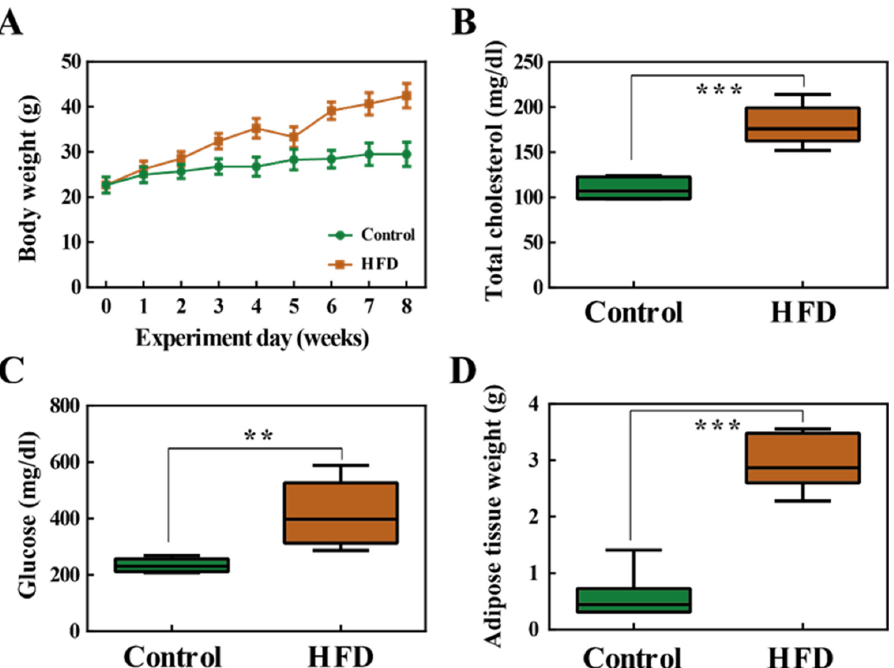
Figure 1. ( A ) Body weight changes in the control group and high fat diet (HFD) group. ( B ) Total cholesterol (TCHO-P III) in serum samples. ( C ) Serum glucose (GLU-P III) levels. ( D ) Weight of the adipose tissue. **, p < 0.01; ***, p < 0.001.